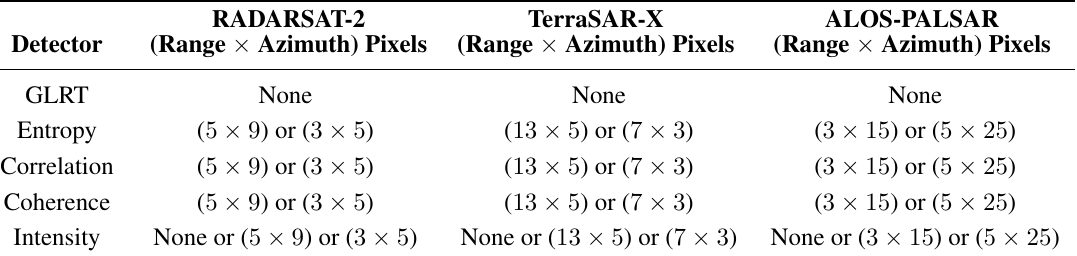
Table 2. Parameters used for boxcar